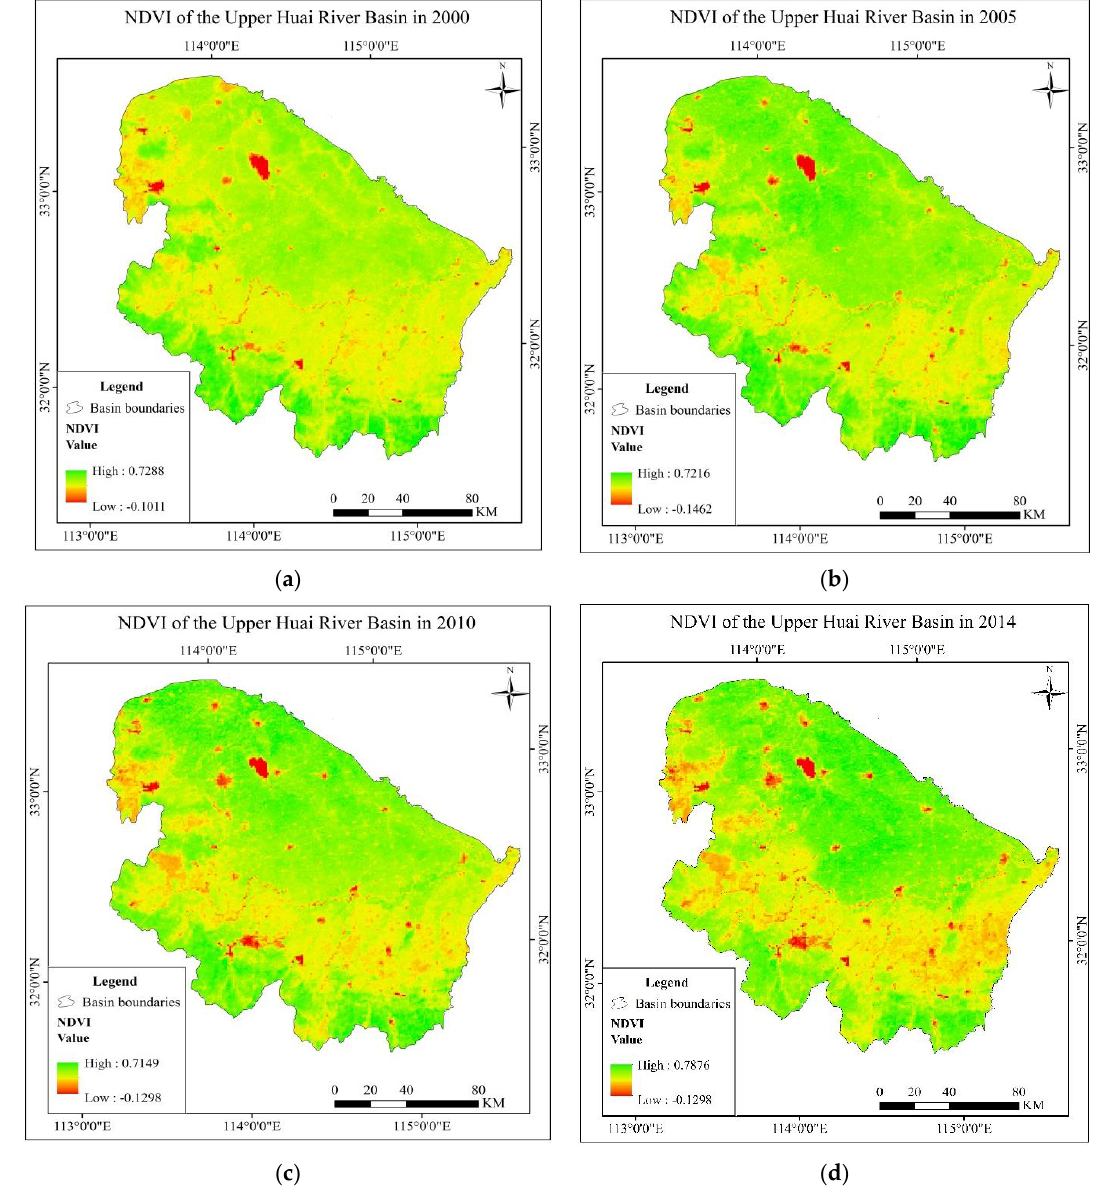
Figure 8. NDVI — the spatial distribution map of the Huai River Basin vegetation. Figure 8. NDVI—the spatial distribution map of the Huai River Basin The pixel ’ s NDVI values ranged from − 1 to 1. The highest NDVI values were greater than 0.6, indicating the healthiest or richest vegetation. The normalized difference vegetation index had a significant difference in the study region. This is due to the prevalence of sufficient precipitation during the period from 1985 onwards. Con- trarily, during 2000, the vegetation coverage had significantly declined, and the per- centage of preeminent coverage area accounted for only about 8.7% of the study region. This was principally because the total mean annual precipitation significantly declined [44]. For the period from 2005 – 2014, the area of preeminent vegetation coverage declined by 30%; on the other hand, the area of lower vegetation coverage NDVI < 0.4 increased by about 75%. The major reason for the vegetation boost was the prevalence of adequate precipitation throughout the summer season [44], and to some extent, harsh climatic